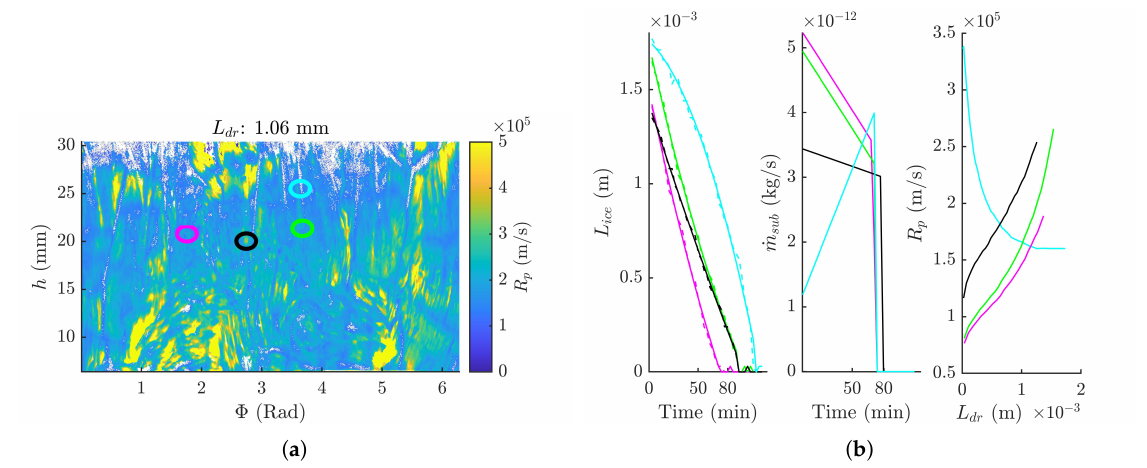
Figure 7. ( a ) R p at a L dr of 1.06 mm for every ( Φ , h ) coordinate for the 4% BSA formulation. Four noteworthy different regions (circles) were selected in the surface plot. ( b ) Following data were plotted for each of the selected point: L ice in function of time (left) with dashed lines the raw data and full lines the smoothed data; ˙ m sub in function of time (middle); R p in function of L dr